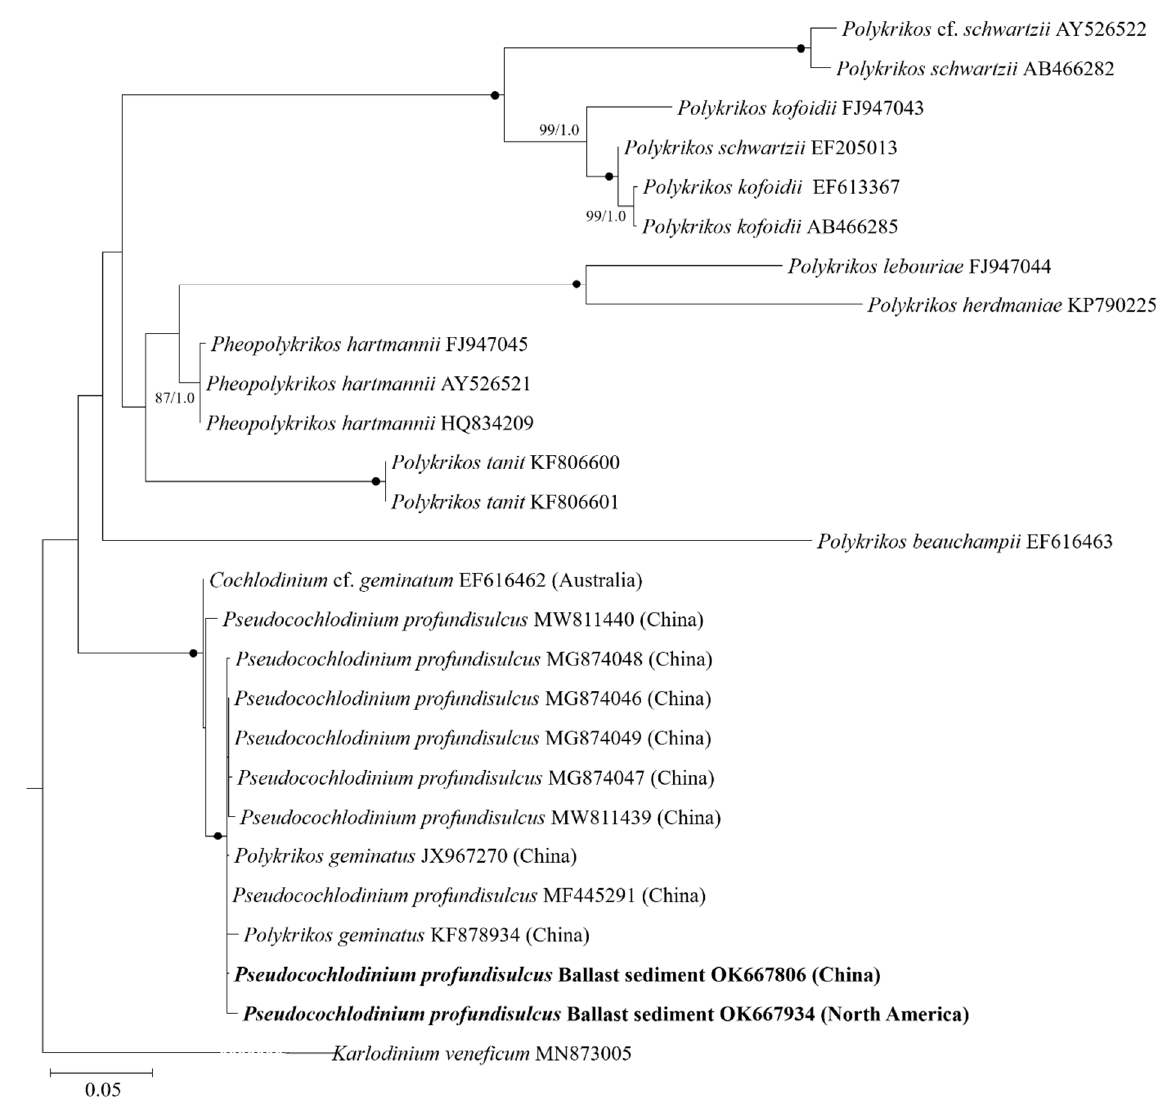
Figure 2. Phylogenetic tree of the Pseudocochlodinium profundisulcus based on the large subunit rDNA sequences. Karlodinum veneficum was used as an outgroup. Bootstrap values >50% and posterior probabilities (PP) above 0.5 are shown. Black dots ( • ) indicate maximal support (PP = 1.00 in BI and bootstrap support = 100% in ML, respectively).